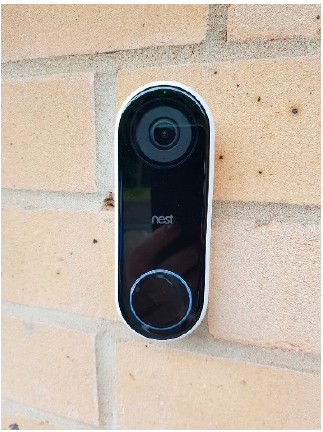
Figure 15. A motion sensor camera. Permission granted and photograph taken by Leicester.